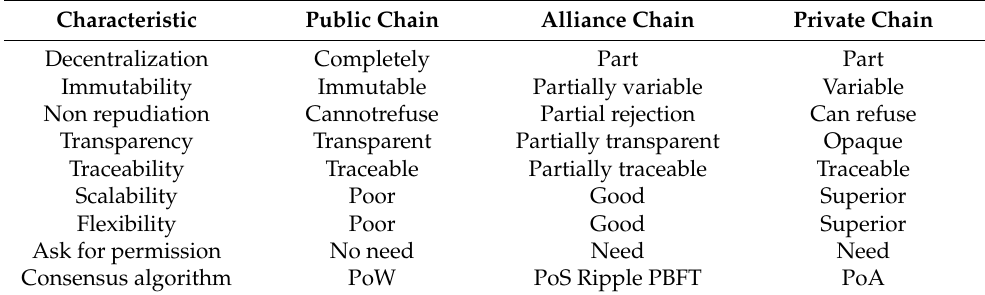
Table 1. Comparison of blockchains.